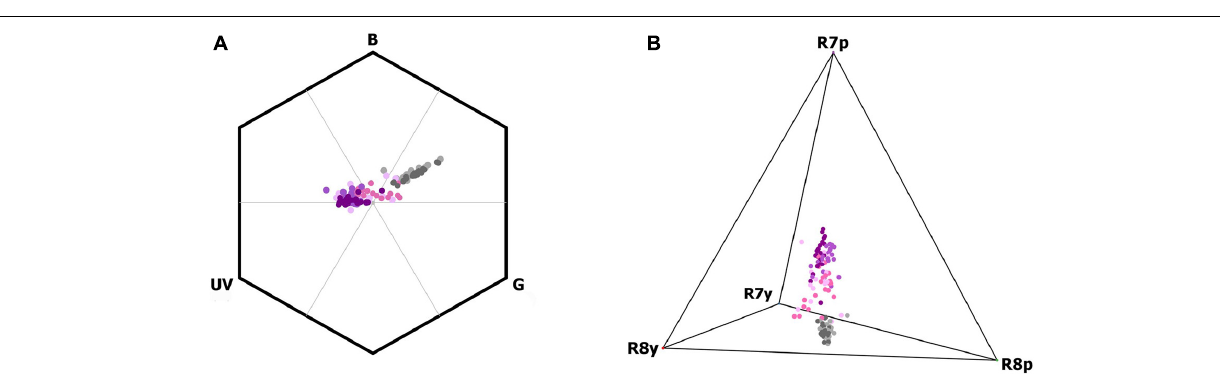
FIGURE 4 | Color loci (circles) of different inflorescence parts of Neotinea ustulata varieties (purple: dark top; pink: hood; gray: lip) plotted within the vision color models of (A) bees (bee-hexagon) and (B) flies (fly-tetrahedron). Var. ustulata : dark-colored tones (i.e., light purple, light pink, light gray); var. aestivalis : light-colored tones (i.e., dark purple, dark pink, dark gray). Bee (UV, B, G) and fly (R7p, R7y, R8p, R8y) receptors are